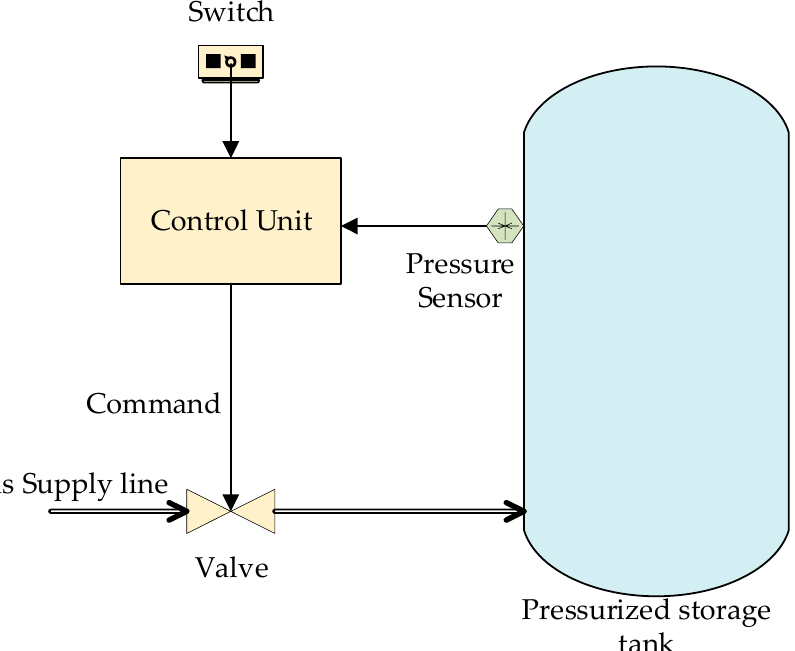
Figure 1. Schematic of the subsystems of the reactor unit.